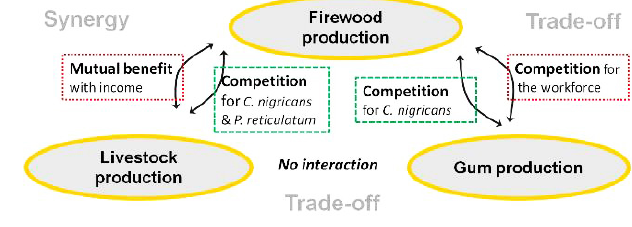
Fig. 6 . Relations observed and interactions